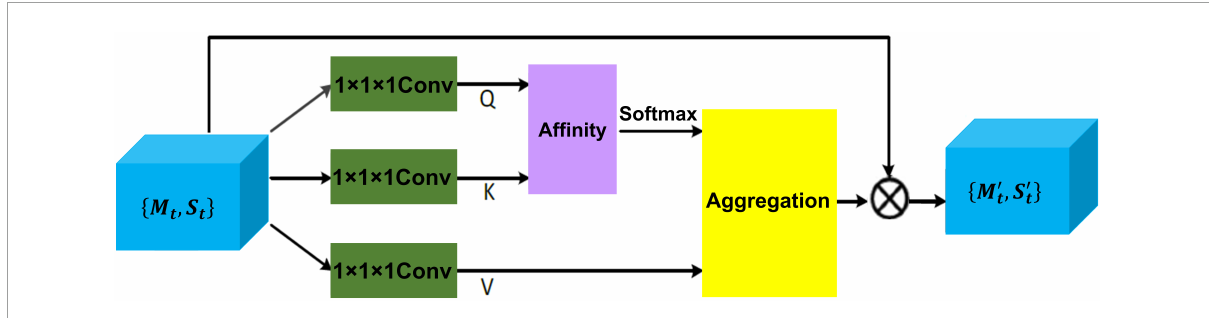
FIGURE3 The details of cross-attention architecture to extract the cross-correlation of multimodal features. Q, K, and V represent all extracted feature maps. { M t , S t } is the disease feature representation, and { M (cid:48) t , S (cid:48) t } is the final representation.